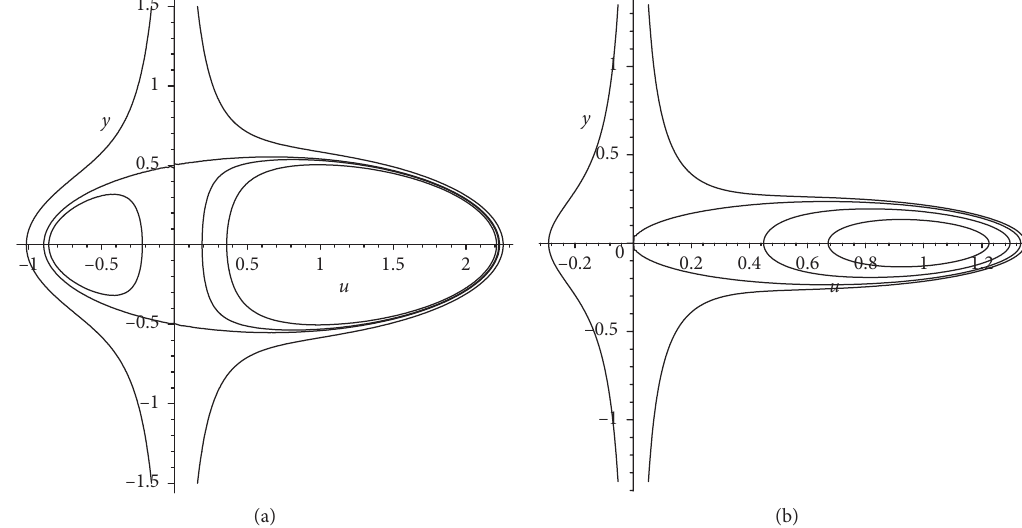
. (b) g < g < g . (c) g � g 1 2 1